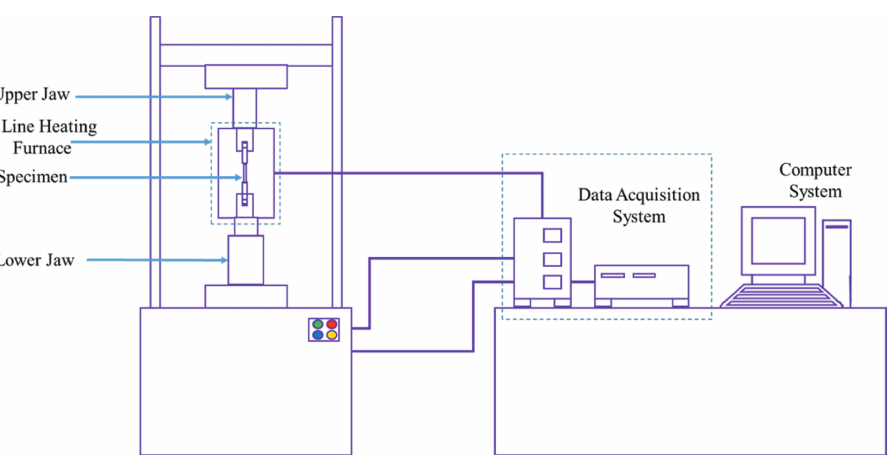
Figure 2: Schematic diagram of UTM of 100 kN capacity with resistance heating three zone furnace.